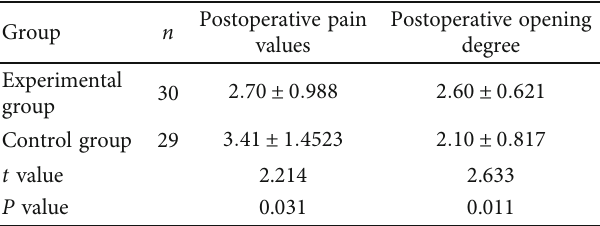
Table 2: Comparison of postoperative pain values and opening degree after M3